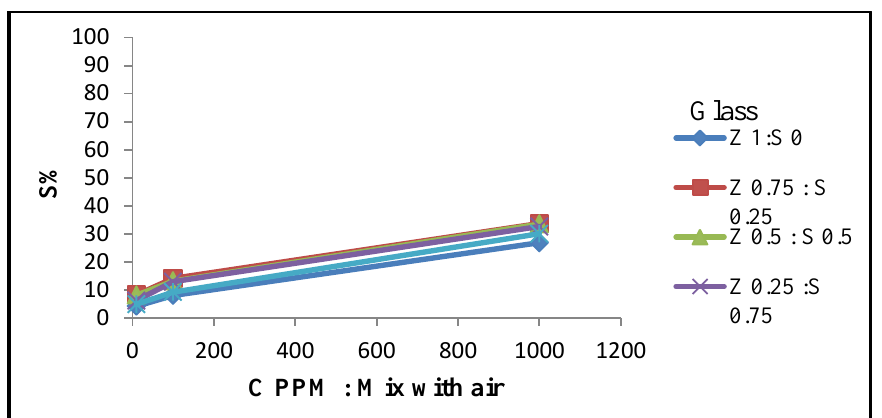
at different mixed 4